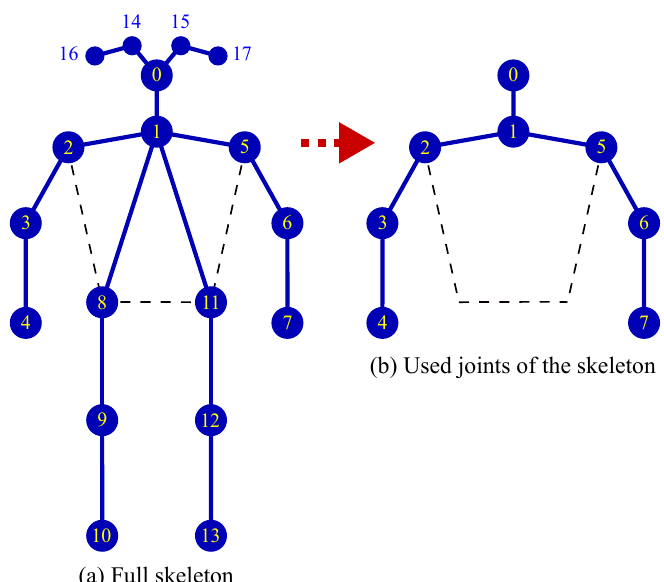
Figure 5. Preprocessing and selection of skeleton